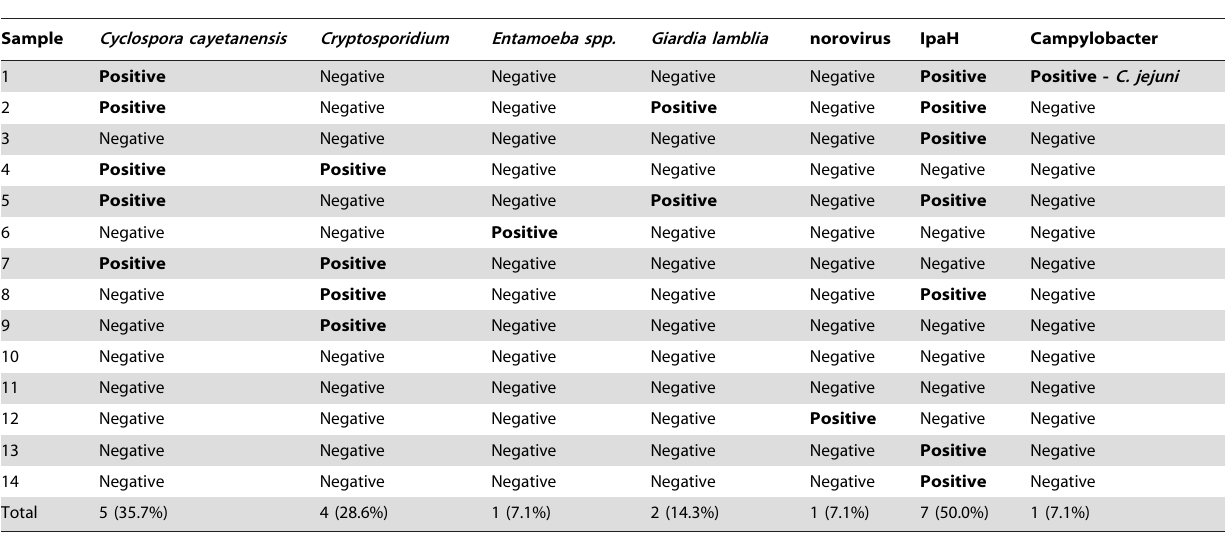
Table 4. PCR detection of enteropathogens (n=14) among 14 samples collected from personnel reporting diarrhea in El Salvador.